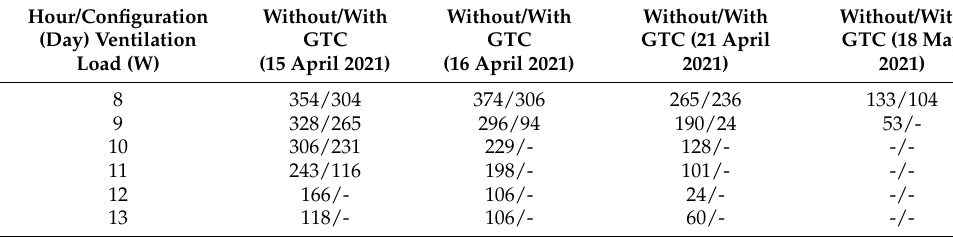
Table 10. Experimental building ventilation load without/with